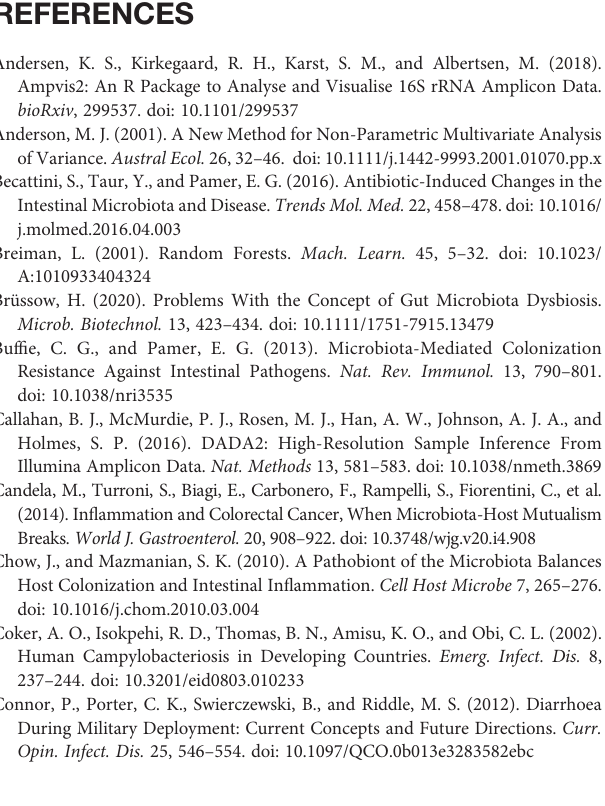
Microbiome Library (circles) (Poyet et al., 2019). Samples from this study are shown grouped by study period (e.g., pre-challenge, inpatient, post-antibitoic administration, and post-discharge). Supplementary Figure 3 | Heatmap showing samples grouped by study period (e.g., pre-challenge, inpatient, post-antibitoic administration, and post-discharge), with the most abundant ASVs shown. Gray squares indicate an ASV was not detected. Supplementary Figure 4 | Extended heatmap showing all samples, with the 50 most abundant ASVs shown. Samples are grouped by study period (e.g., pre- challenge, inpatient, post-antibitoic administration, and post-discharge). Supplementary Figure 5 | Principal coordinate analysis (PCoA) of samples from the pre-challenge (blue) to post-discharge period (red). PCoA was generated from a weighted UniFrac distance matrix. Supplementary Figure 6 | Additional differential abundance analyses including comparisons between treatment groups during the pre-challenge period (A) , between study participant samples during the pre-challenge period from study participants who did and did not develop campylobacteriosis (B) , and fi nally samples taken after antibiotic administration during the inpatient period in study participants who did and did not develop campylobacteriosis (C)